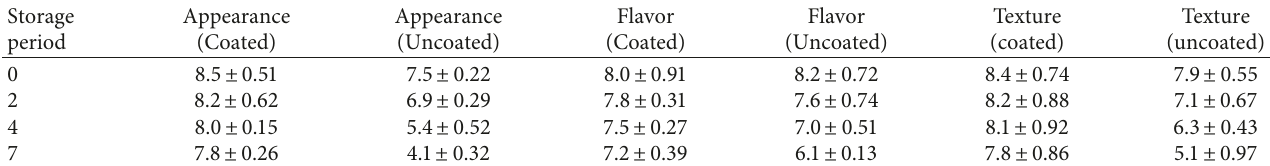
Sensory parameters scale corresponds to 9 � excellent and 1 � extremely